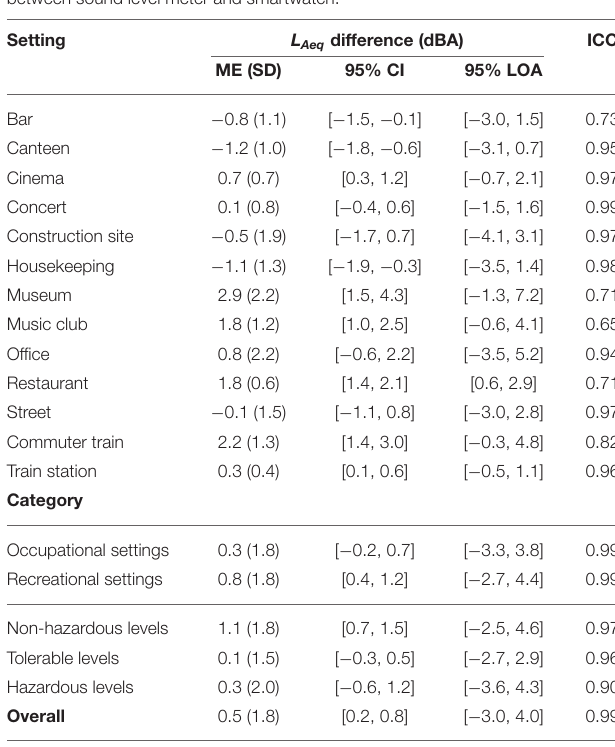
TABLE 3 | Noise exposure differences and intra-class correlation coefficient (ICC) between sound level meter and